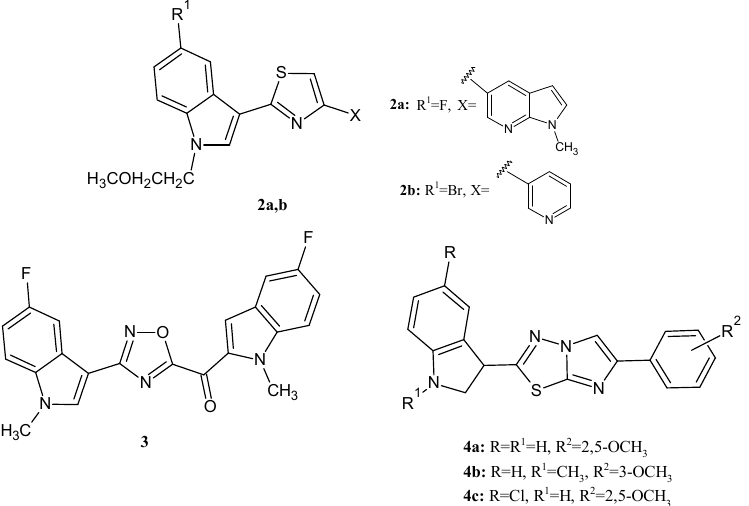
Figure 2. Indole compounds 2–4 with potent inhibitory activity against staphylococcal biofilm for ‐